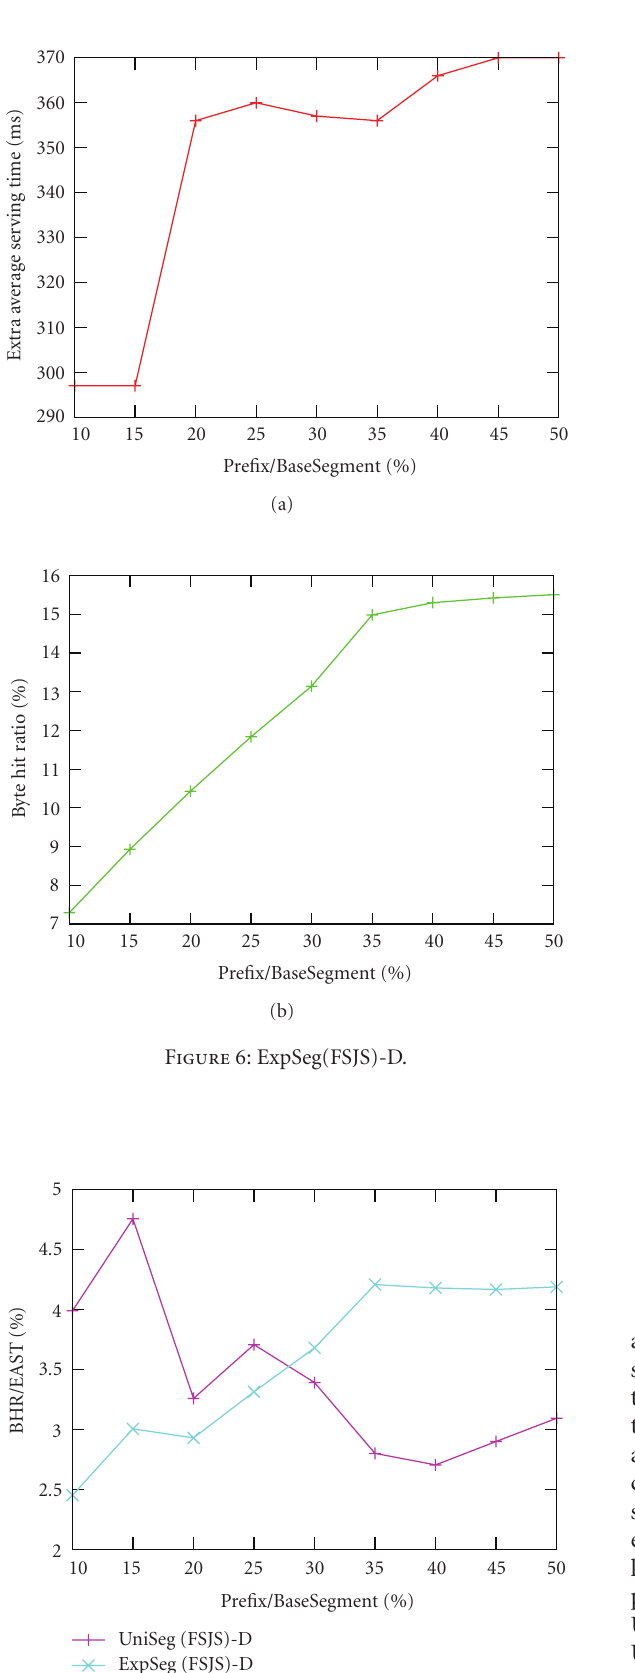
Figure 7: Finding the best point.